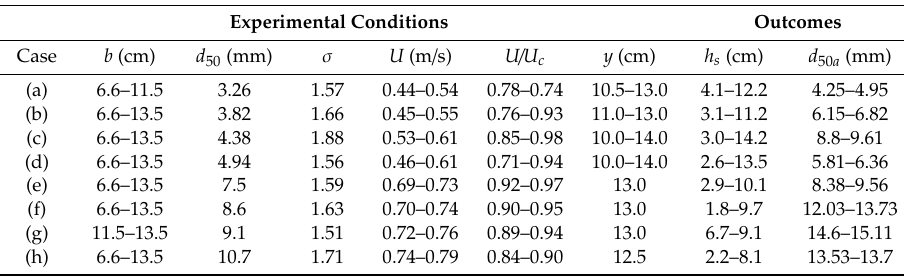
Table 1. Experimental data of non-uniform gravel bed.